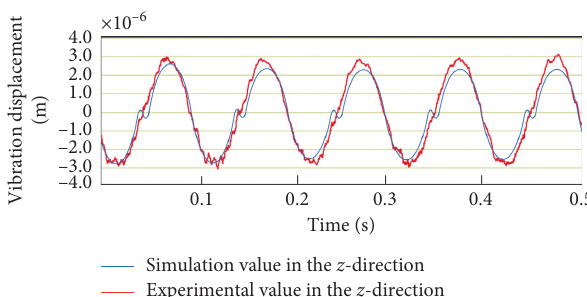
Figure 12: Comparison of experimental values and simulated values of axial vibration displacement at 300r/min.